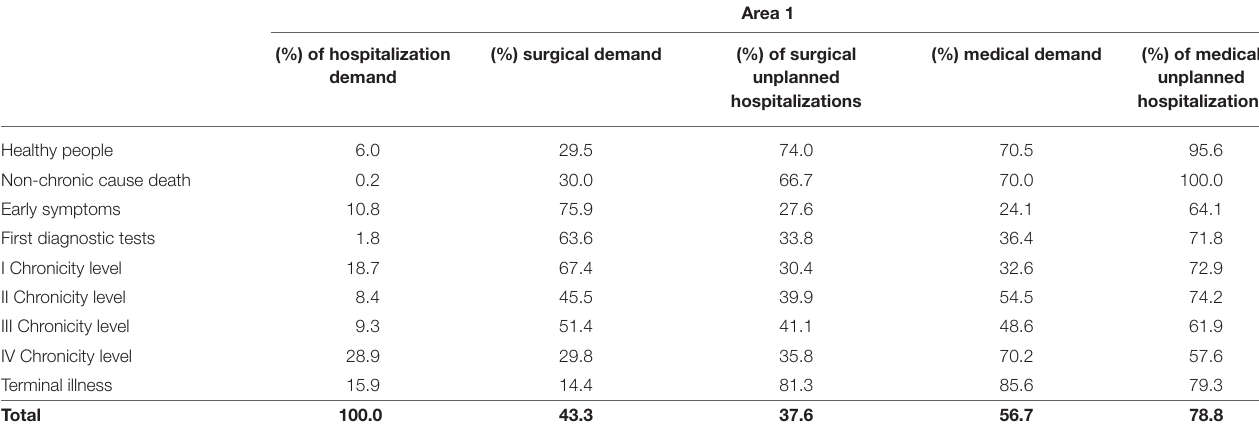
TABLE 1 | Overall hospitalization demand Area 1.